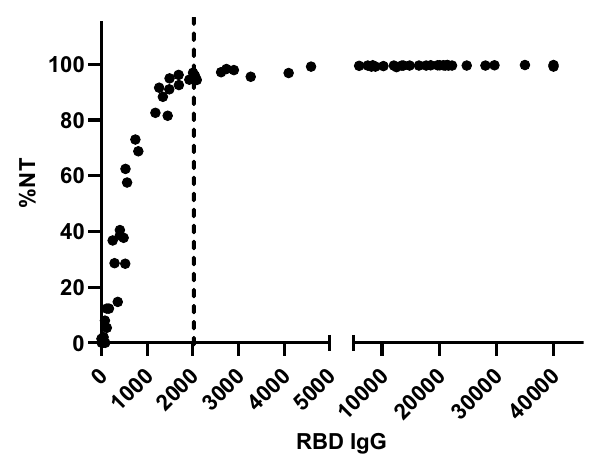
Figure 1. T-cell response against the spike (S) protein ( A ) and nucleocapsid (N) protein, membrane glycoprotein (M) and ORF1ab region of RNA-dependent RNA (O) of SARS-CoV-2 ( B ) evaluated by ELISPOT (P < 0.0001, t = 5.720, df = 77). SFCs spot-forming cells, PBMCs peripheral blood mononuclear cells.